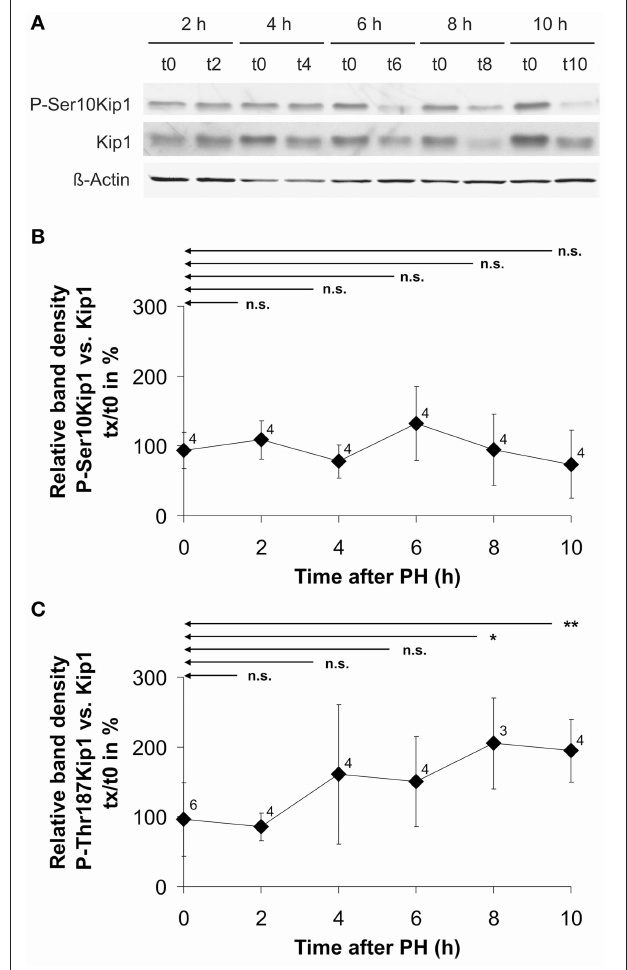
FIGURE 6 | Example image of a Western blot for the quantification of Kip1 phosphorylation level (A) and Kip1 phosphorylation levels at Ser10 (B) or Thr187 (C) in rat liver tissue obtained during PH (t0) as well as in residual liver tissue at different times after partial hepatectomy (tx). (A) Proteins were extracted from samples of liver tissue obtained from individual rats during partial hepatectomy (t0) or during the second operation after different times of regeneration of residual liver tissue in the animals (tx). Blots were probed using phospho-specificKip1 antibodies (P-Ser10Kip1) and, upon stripping, with antibodies against Kip1 (Kip1) and antibodies against β -actin ( β -Actin). The latter signals were used as loading controls. For generating the diagrams (B) and (C) , the optical density of the P-Kip1 bands of each individual animal was normalized to that of the Kip1 bands (expressed in %). Plotted in the graphs are the percentages of P-Kip at the different times after PH relative to the amount of P-Kip under control conditions (0h). Data points represent means ± SD of different tissue samples from n different animals, each analyzed at least in triplicate (n.s., p ≥ 0 . 05; ∗ p < 0 . 05; ∗∗ p < 0 .